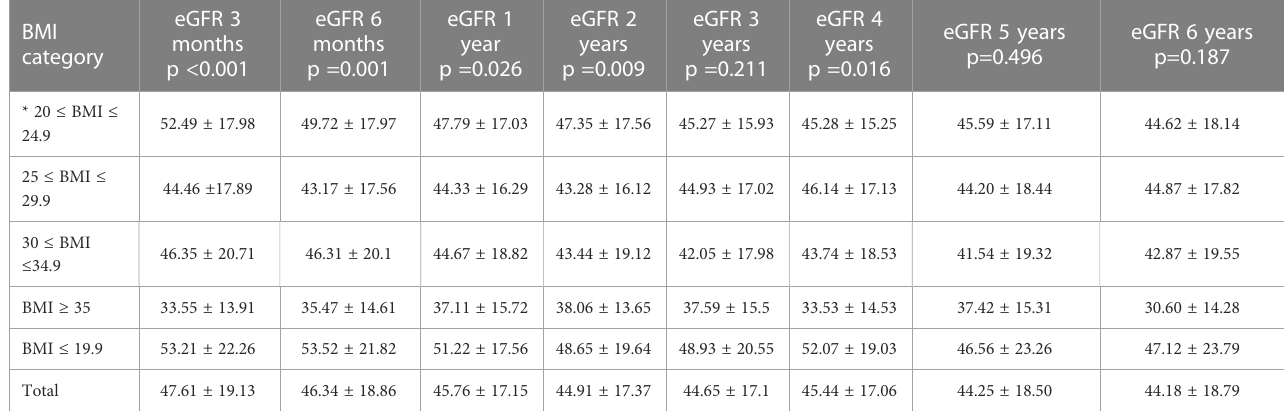
TABLE 2 Mean and standard deviation for kidney function during follow up per BMI category.